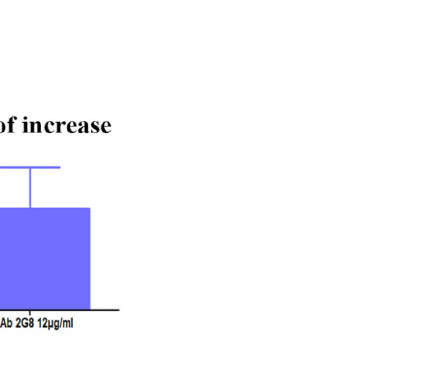
Figure 4. Binding to laminarin: comparison between the murine mAb 2G8 and the humanized H5K1 through ELISA assay ( A ) and the interpolated ROC curves of the ELISA assays’ mean ( B ). Binding to the other cell wall components: mannan ( C ), chitin ( D ) and β-1,6-glucans ( E ).